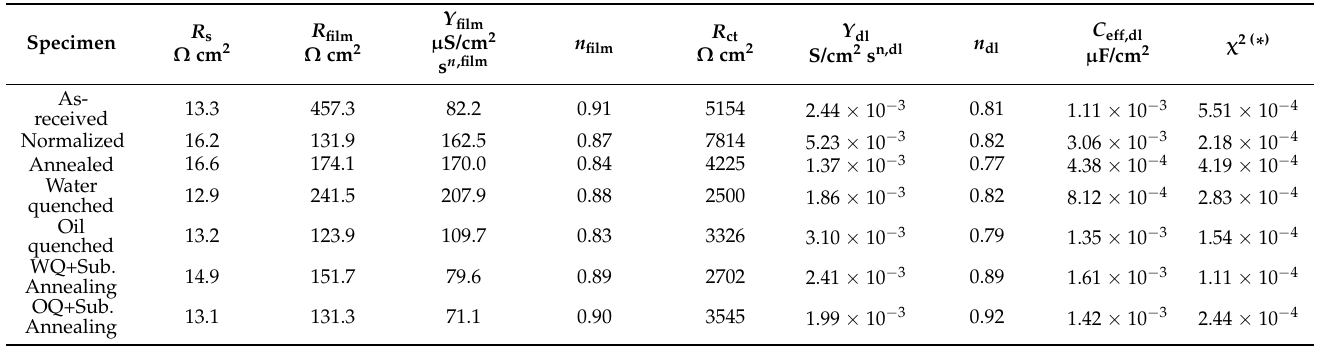
Figure 9. Bode plots of the thermomechanical treated CS rebars in FA pore solution containing 0.6 M NaCl: ( a ) slow cooling rate, and ( b ) fast cooling rate. Table 3. EIS fitting parameters of CS samples in FA pore solution (pH